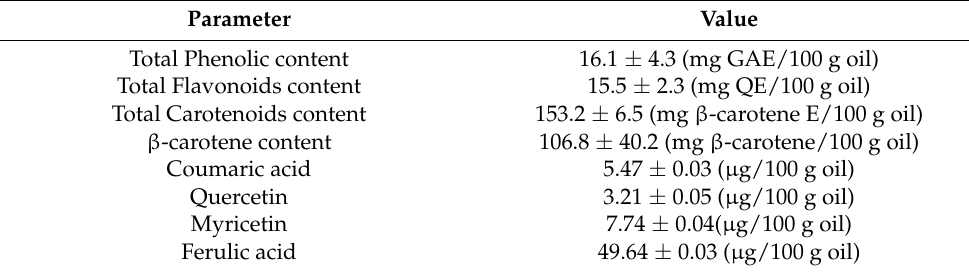
Table 3. Phenolic and carotenoid compound contents in Mayten tree seed